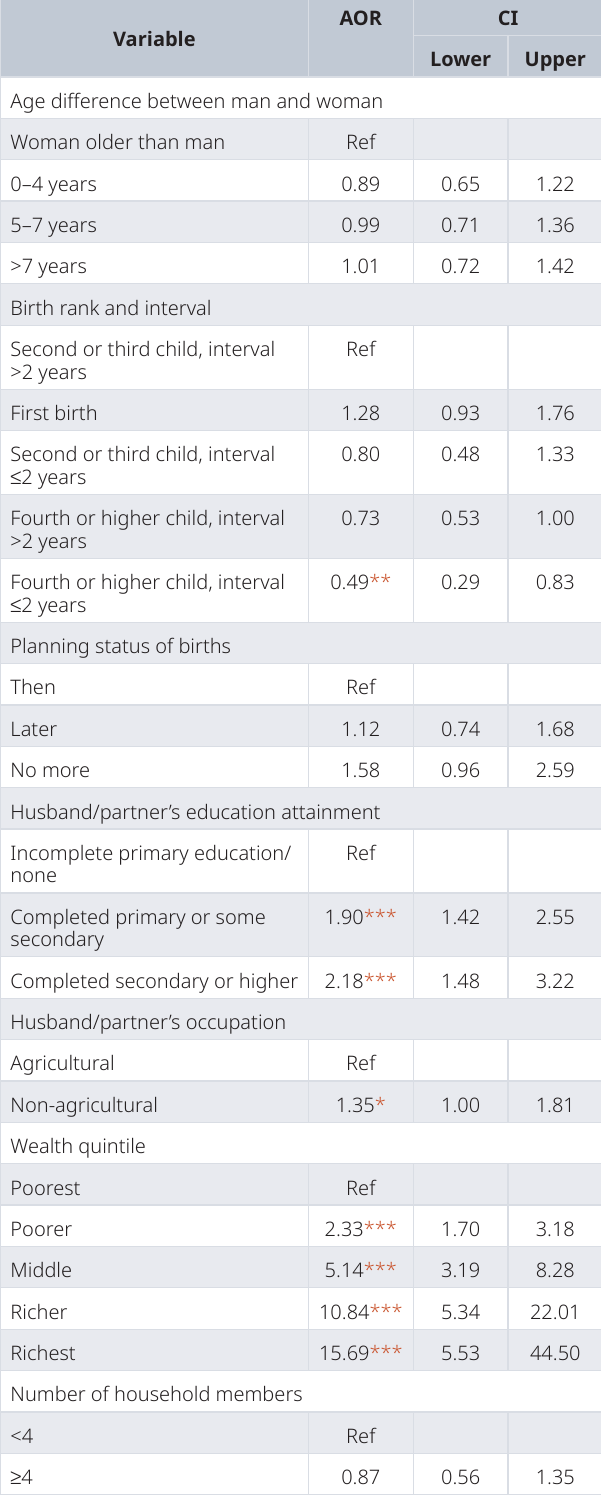
Table 5. Binary logistic regression analysis with type of assistance at